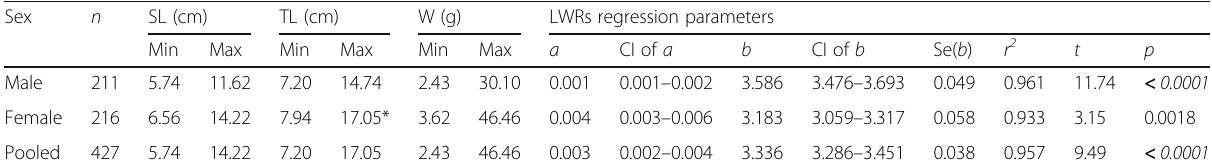
Table 1 Descriptive statistics, estimated parameters of LWRs ( W = a × L b ) for Pachypterus khavalchor from Panchaganga River (tributary of Krishna River System) of the northern Western Ghats of India sampled during June 2015 to May